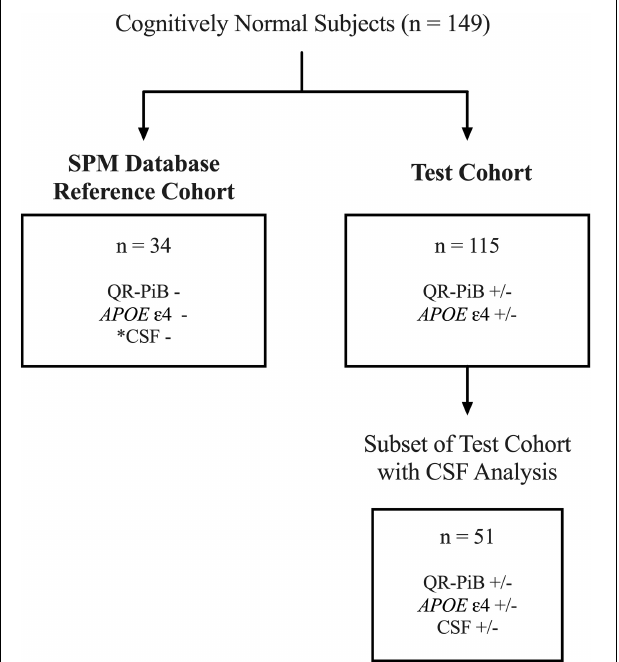
FIGURE 1 | Workflow for the selection of the SPM database reference cohort and test cohort subjects. Of 149 total subjects, 34 cognitively normal, APOE-, QR-PiB-, CSF– subjects were selected to construct the SPM database. *CSF was negative for A β 42, p-tau, and t-tau biomarkers. The remaining 115 subjects comprise the test cohort. A subset of 51 of the 115 test cohort subjects had CSF available for